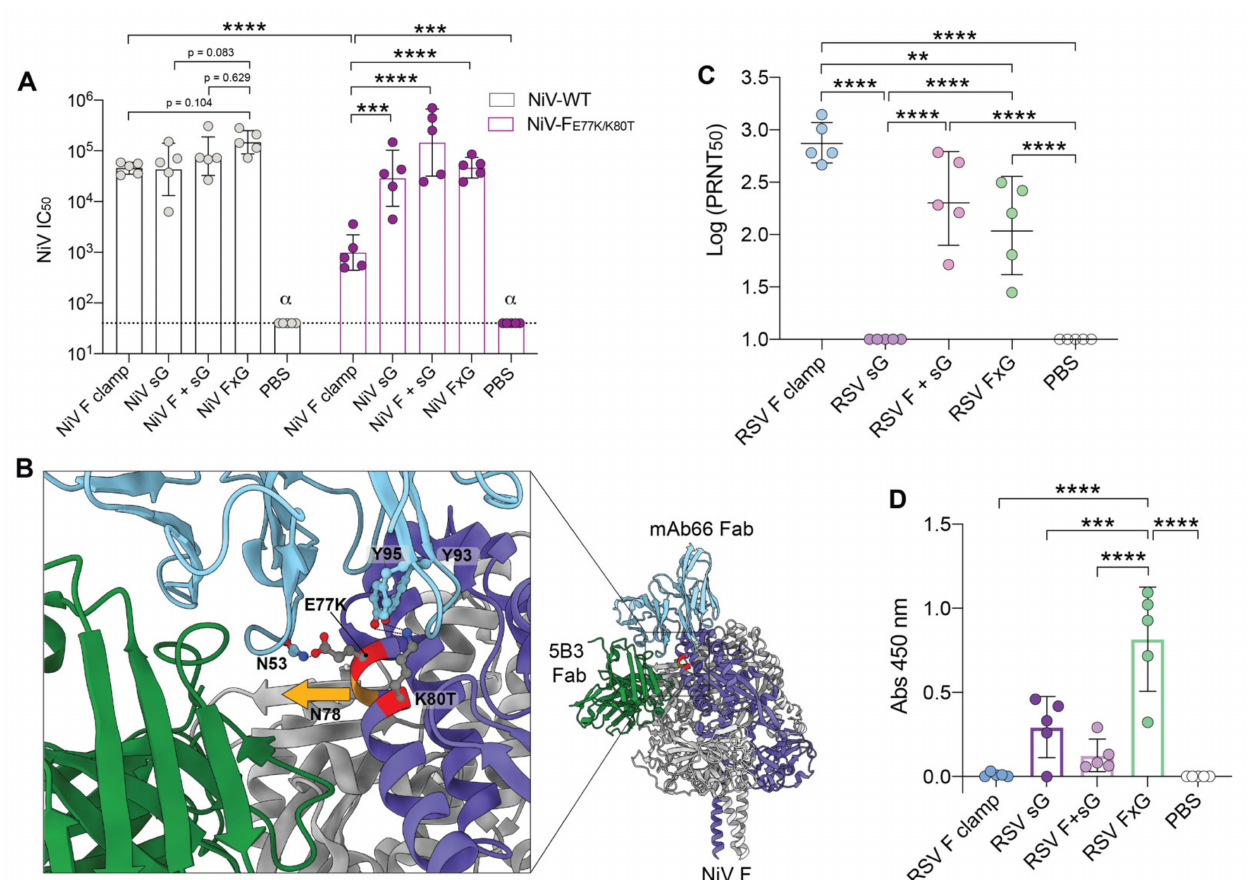
Figure 4. Terminal bleed sera neutralisation of NiV pseudovirus and RSV. ( A ) NiV antigen vaccinated sera neutralisation of WT-NiV or NiV-F E77K/K80T epitope-knockout pseudovirus. Dotted line shows limit of detection. ( B ) Structural represen- tation of NiV-F E77K/K80T mutations. NiV F monomer coloured in purple with E77K and K80T mutations highlighted in red. 5B3 Fab (PDB 6TYS) coloured in green and mAb66 Fab (PDB 6T3F) coloured in cyan. Residues of 5B3 and mAb66 that interact with E77 or K80 on NiV-F are annotated & displayed as stick figures. A potential glycan site is formed on NiV F N78 (orange) with the proposed glycan orientation depicted by the orange arrow. ( C ) Serum samples from RSV groups tested in a plaque reduction neutralisation test (PRNT) against RSV A2 virus. In ( A , C ), data represents geometric mean with geometric SD and p -values calculated using Tukey’s multiple comparison ANOVA on log transformed values, where ** = p < 0.005, *** = p < 0.0005 and **** = p < 0.0001. α denotes p < 0.0001 against all groups unless otherwise specified. ( D ) RSV serum samples (1:10 dilution) tested for reactivity against the CCD of RSV G (MBP-CCD) in an indirect ELISA. Data shows mean with SD, with background binding against MBP subtracted. p -values calculated using a one-way Tukey’s multiple comparison ANOVA, where *** = p < 0.005 and **** = p < 0.0001. Non-significant comparisons are not